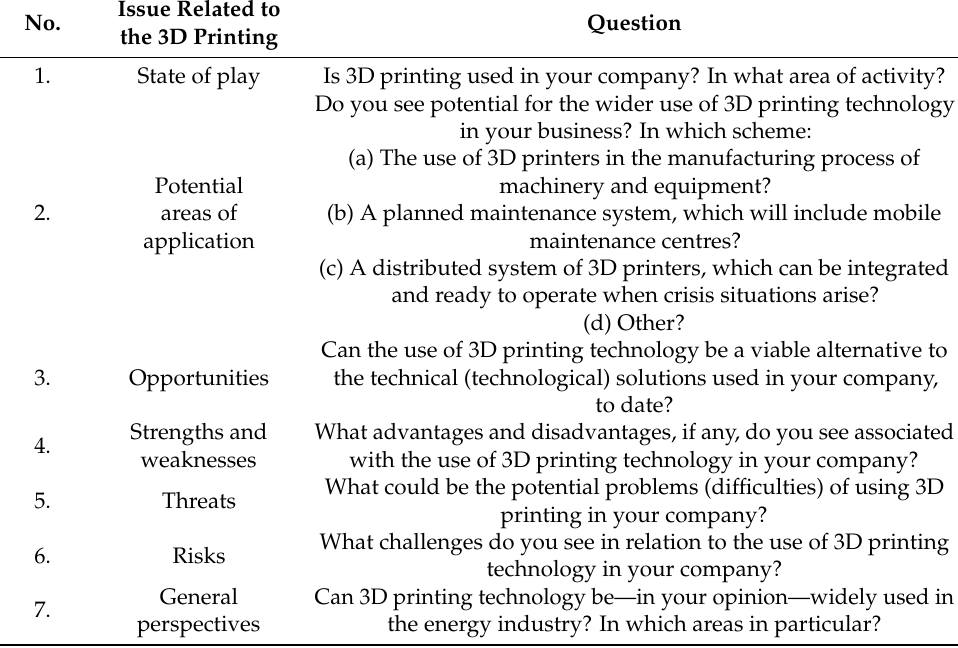
Table 1. Main issues of the in-depth